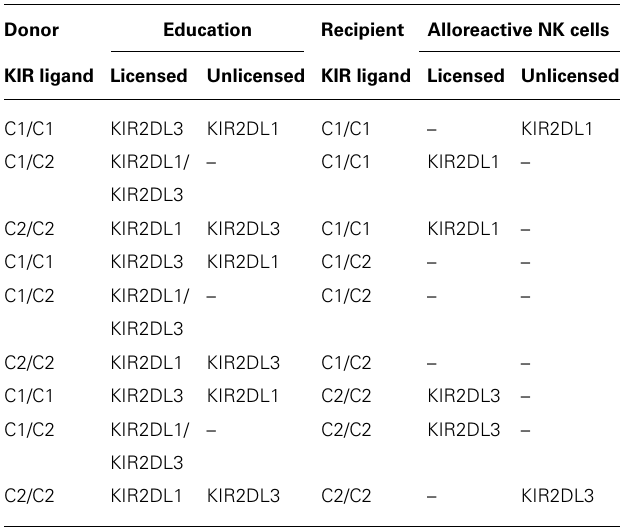
Table 1 | Pattern of NK cell licensing and alloreactivity for HLA-C-encoded KIR